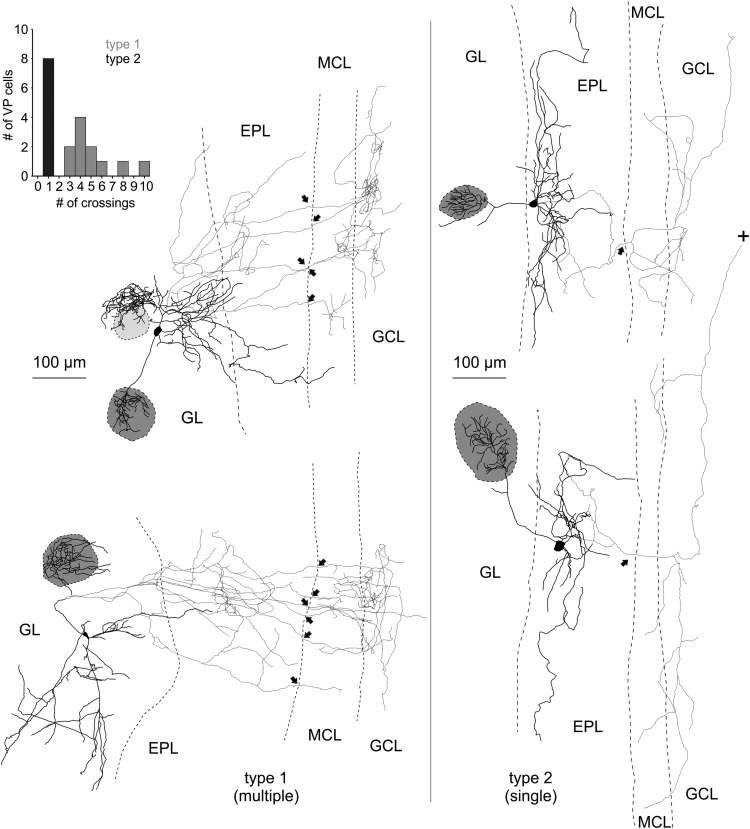
Reconstructions of eGFP-VPCs labeled with biocytin. Two representative examples of type 1 (multiple innervation of MCL; left) and type 2 cells (single top-down innervation of MCL; right). +, Truncation of axonal projection; arrows, site of axonal MCL crossing from EPL into GCL. The dark gray shading indicates the glomerulus innervated by the dendritic tuft of the respective VPC. Light gray shading indicates that dendrites lie above or below respective glomerulus. The VPC in the top left displays a conspicuous dendritic ramification that does not enter the adjacent glomerulus. Similar structures were found in 4 of 35 reconstructed cells. Inset, Number of crossings versus number of cells.